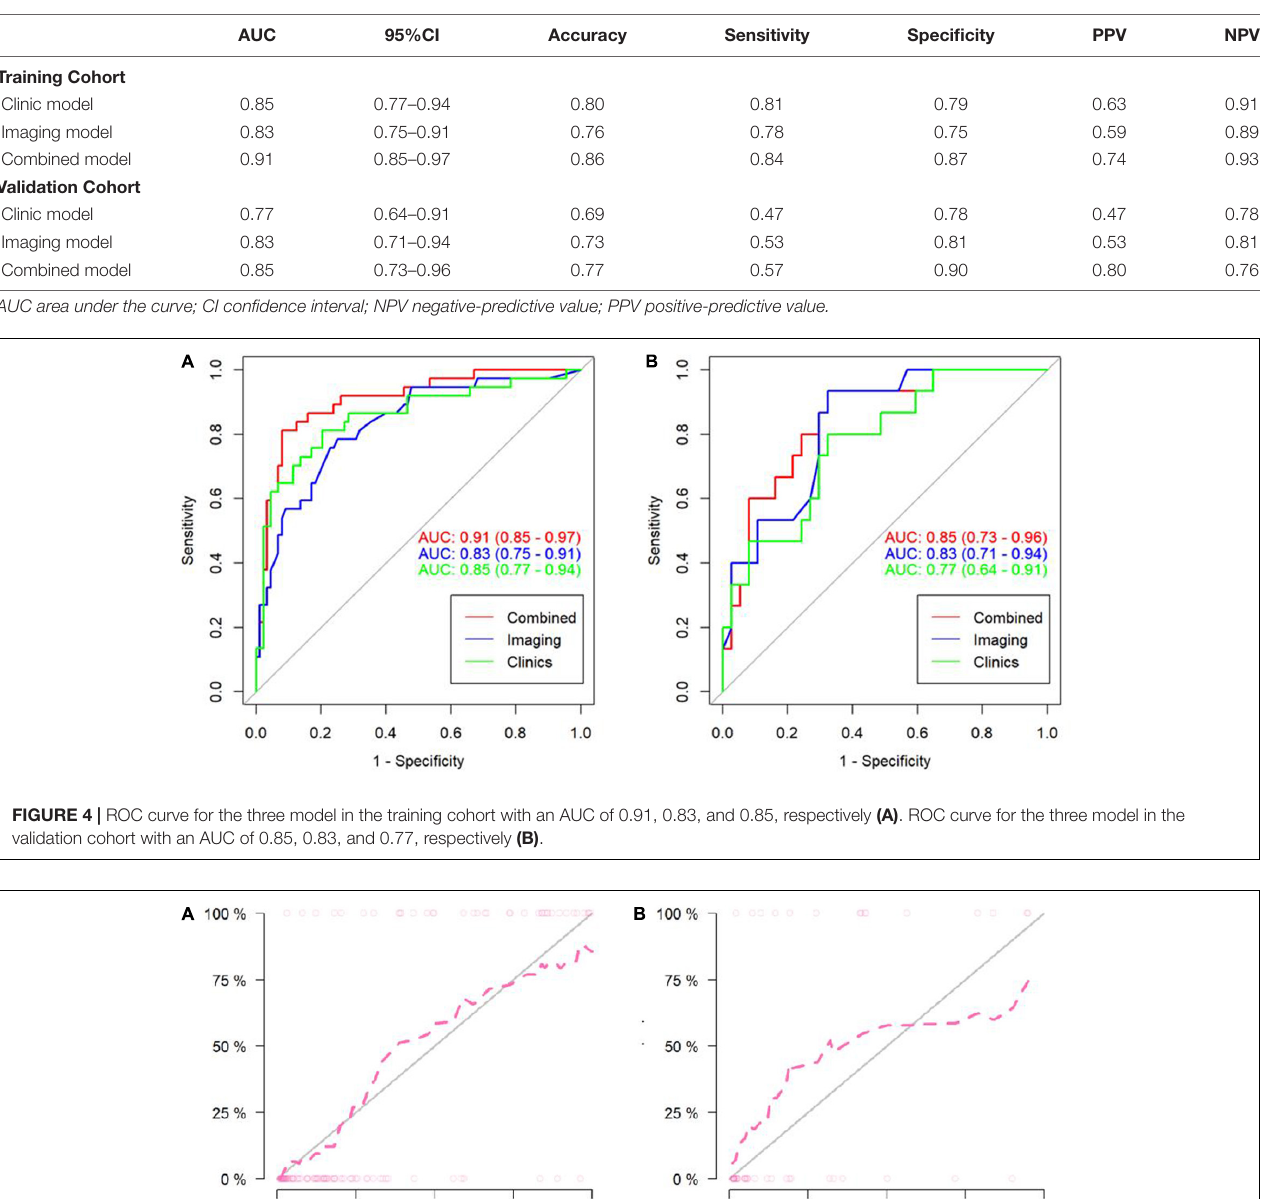
TABLE 3 | Accuracy and predictive value between three models.